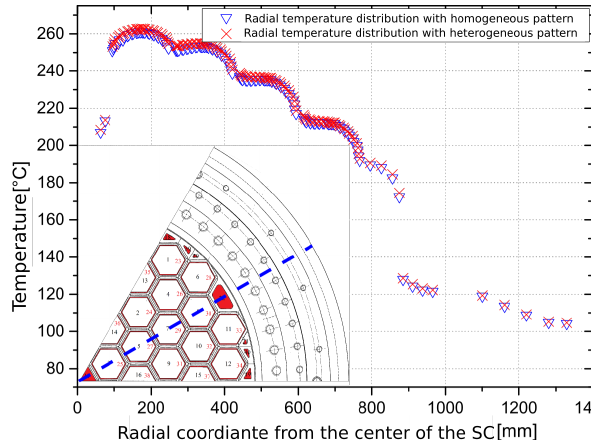
Figure 8. Radial temperature distributions for ho- mogeneous and heterogeneous radial peaking factors in the SC CASTOR 440/84 with the reference pat-